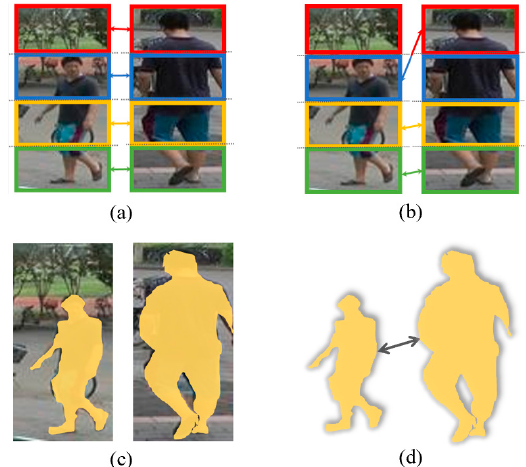
Figure 1. Comparison of part-based methods: ( a ) Dividing images into rectangle parts; ( b ) part alignment model; ( c ) proposed dynamic and accurate attention parts based on body regions; and ( d ) explicitly and stable correspondence between parts.